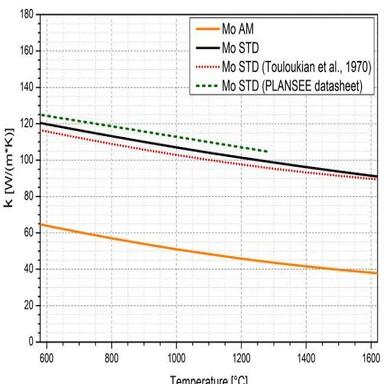
Comparison of the thermal conductibilities of Mo STD and Mo AM.